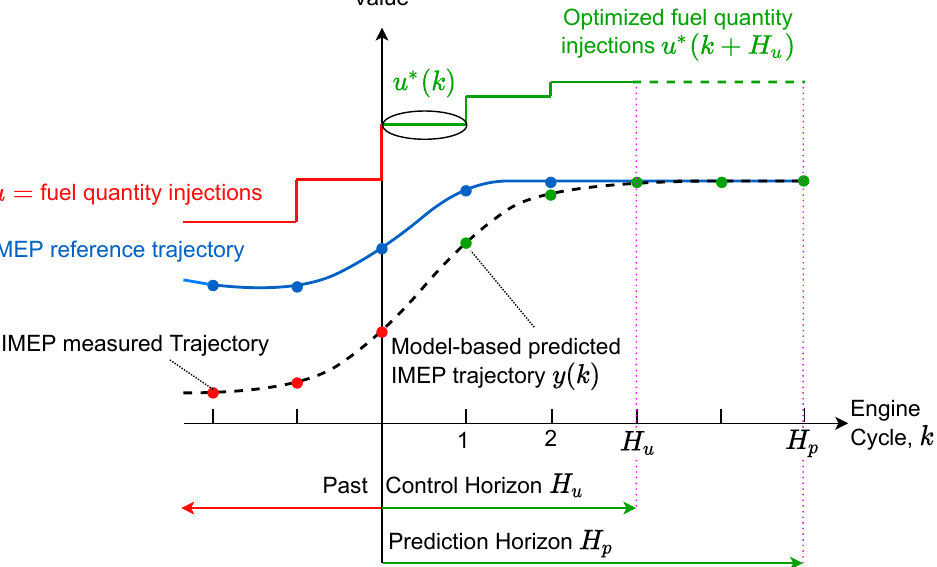
Figure 2. The MPC control concept and prediction receding horizon: illustrated for engine load